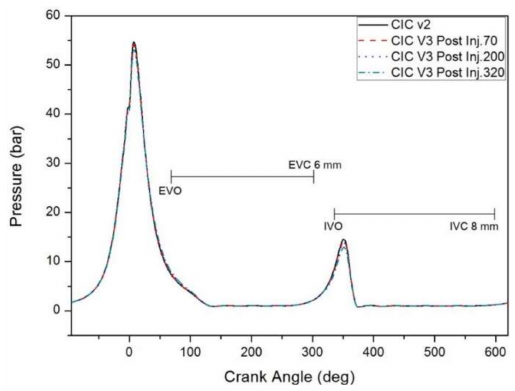
Figure 13. Pressure variation for different recompression strategies with three post